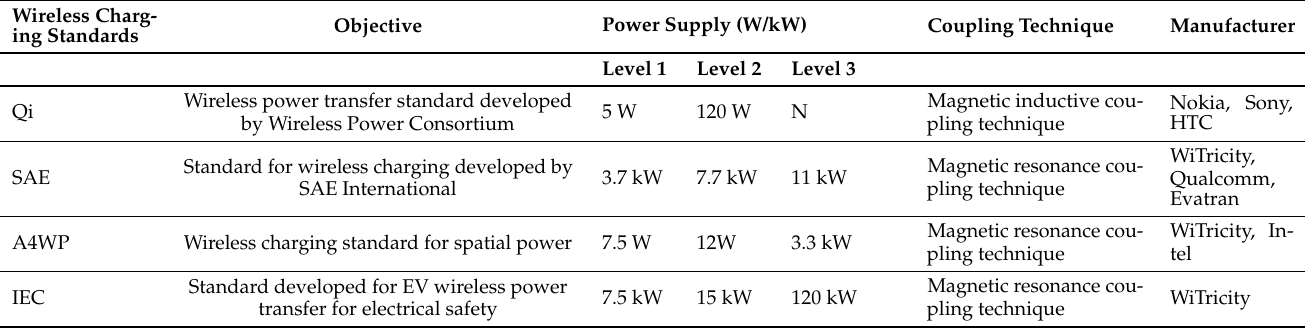
Table 5. Comparison of wireless charging standards based on the power supply and coupling technique